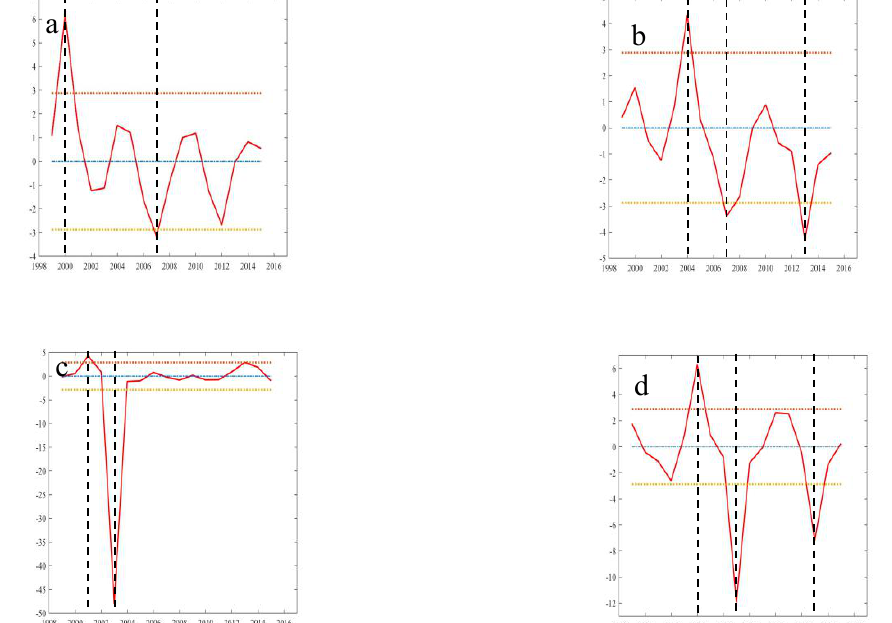
Figure 3. Regime Shift Index (RSI) based on the Student’ s t-test from 1998 to 2017: ( a ) WPI TN ; ( b ) WPI TP ; ( c ) WPI DO ; ( d ) WPI COD .